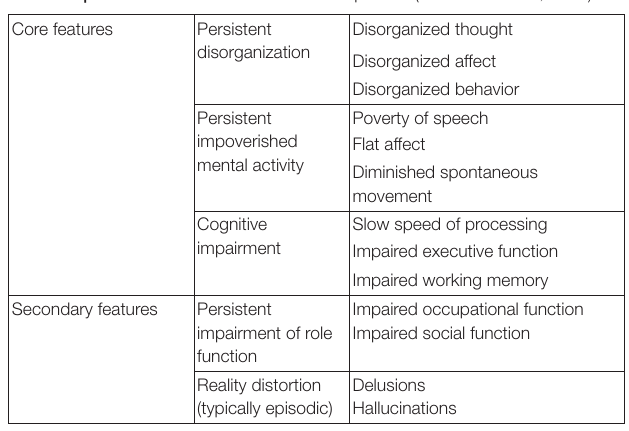
TABLE 1 | Clinical Features of classical schizophrenia (based on Liddle,